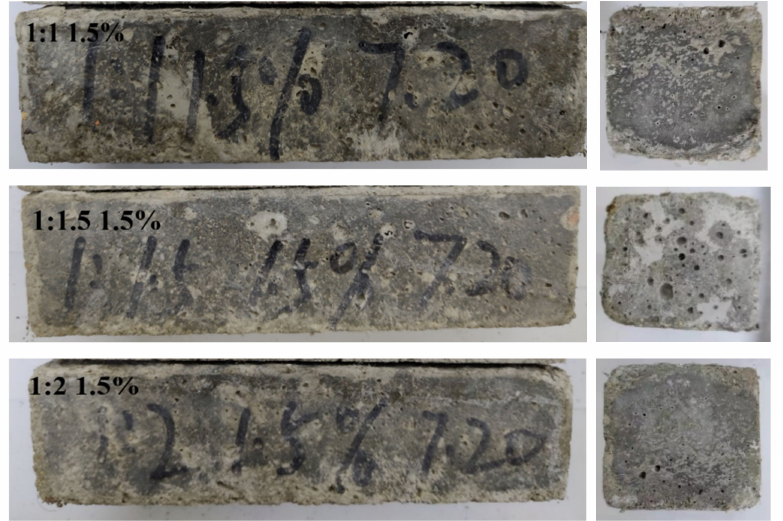
Figure 6. Appearance of C/S values of 1:1, 1:1.5, and 1:2, and 1.5% dosage of treated PP fiber mortar specimens after 150 dry-wet